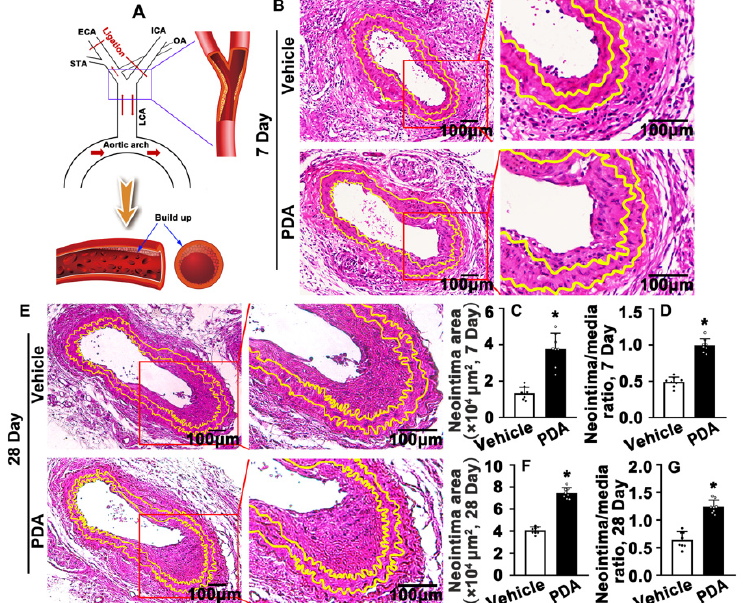
Figure 1. PDA promotes partial carotid artery ligation-induced neointima formation in a model of vascular injury. ( A ) Schematic diagram of the left carotid artery partial ligation model showing a ligation injury caused by vascular remodeling. ( B ) Partial ligation of the left carotid artery in ApoE − / − mice. PDA (20 mg/kg) was administered by intraperitoneal injection for 7 consecutive days. The arteries were harvested and embedded in paraffin. A 5 μ m thick paraffin section was collected at the ligation site. H&E staining was performed to observe the morphological changes in blood vessels. ( C , D ) Analysis areas of the neointimal hyperplasia and ratio of the neointimal areas to the medium layer area ( n = 8). ( E ) Partial ligation of the left carotid artery in ApoE − / − mice. PDA (20 mg/kg) was administered by intraperitoneal injection for 21 consecutive days. Representative image of H&E staining. ( F , G ) Analysis areas of the neointimal hyperplasia and ratio of the neointimal areas to the medium layer area ( n = 8). Data are expressed as means ± SEM. * p < 0.05.